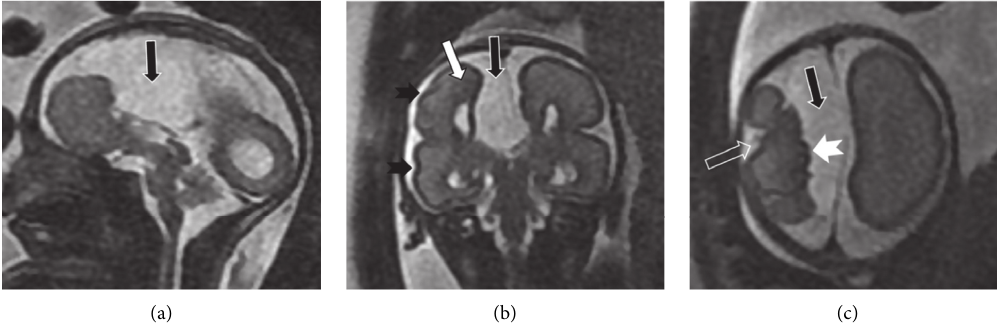
Figure 2: Complete agenesis of corpus callosum. Gestational age: 27 weeks. (a) Sagittal SSFSE T2. (b) Coronal SSFSE T2. (c) Axial SSFSE T2. Complete agenesis of corpus callosum with right interhemispherical cyst with mass effect (solid black arrow) is shown. The right cerebral hemisphere is smaller in size, and malformation of cortical development is evident, with multiple anomalous sulci, bumpy cortical surface (solid black arrowhead), and cortical invaginations (empty white arrow). Regions of associated polymicrogyria (solid white arrowhead) and heterotopias bulging on the ventricle wall are depicted (solid white arrow). Fetal MRI provides useful information for perinatal management and prognosis over fetal ultrasound by detecting anomalies of the cerebral cortex and heterotopies not visible in the fetal ultrasound.